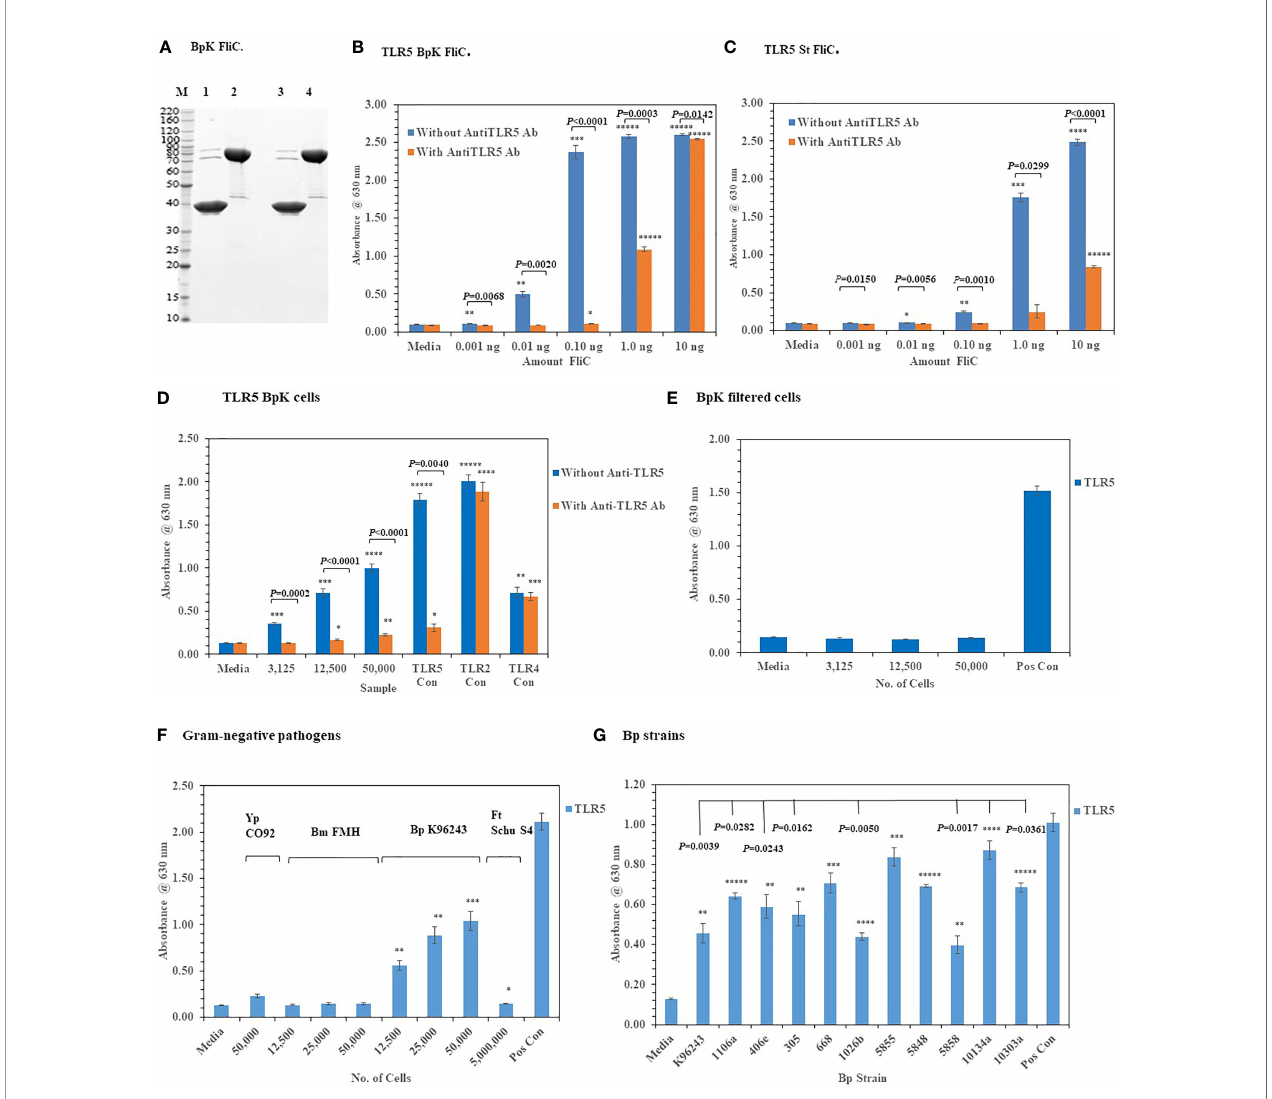
FIGURE 7 | Activation of TLR5 by either fl agellin or fl agella. (A) Polyacrylamide gel electrophoresis (10.5 − 14% Criterion, Tris-HCl gel) of puri fi ed Bp K96243 fl agellin preparations (5 µg each): M, marker; lane 1, FliC sample heated and reduced, prior to loading; lane 2, His6-MBP-tev-BpKFliC (uncleaved tev Bp K96243 FliC) sample heated and reduced, prior to loading; lane3, FliC, without heating or reducing; lane 4, His6-MBP-tev-BpKFliC without heating or reducing. (B) TLR5 activation by increasing amounts of Bp K96243 FliC with and without anti-TLR5 monoclonal antibody (100 ng). Signi fi cant differences in TLR5 activity with and without anti-TLR5 antibody are shown above. (C) TLR5 activation by increasing amounts of St FliC with and without anti-TLR5 monoclonal antibody (mAb) (100 ng). (D) Activation of TLR5 by live Bp K96243 cells can be inhibited by an anti-TLR5 mAb but not TLR2 or TLR4. Varying amounts of Bp K96243 cells was used to inoculate HEK293-TLR5 cells. Also, HEK 293 -TLR5, -TLR2, and -TLR4 cells with their respective positive control antigens were examined. All TLR activation samples were examined with and without anti-TLR5 mAb (100 ng). (E) Activation of TLR5 after fi ltration of Bp K96243 cells used in Figure 7D . Equivalent amounts of fi ltrate (in 20 µl) that contained 3,125, 12,500, and 50,000 Bp K96243 cells before fi ltration (0.2 µm) was added to HEK293-TLR5 cells and activation evaluated. The positive control was not fi ltered. (F) Activation of TLR5 by live Gram-negative pathogens. Gram-negative pathogens Yp CO92, Bm FMH, Bp K96243, and Ft Schu S4) were grown as described in the Material and Methods, and bacterial cell suspensions were used to inoculate HEK293-TLR5 cells. After overnight incubation (~20 h) at 37°C with 5% CO 2 , the absorbance of the plates were read at 630 nm. The media control was PBS, and the positive control (Pos Con) was St FliC (2 ng). (G) Activation of TLR5 by live cells of Bp spp. Bp spp. listed in Table 1 were grown as described in the Material and Methods and used to inoculate HEK293-TLR5 cells as indicated. After overnight incubation (~20 h) at 37°C with 5% CO 2 , the absorbance of the plates were read at 630 nm. Although different amounts of cells were examined for TLR5 activity (6,250, 25,000, and 100,000 cells), for display purposes we only show the results for 100,000 cells, which gave the highest activity in all cases except one strain (Bp 406e). In this latter case, there was no statistical difference between the two highest cell concentration used. Statistical differences between the Bp strain with highest TLR5 activity ( Bp HBPUB10134a) and the other strains is shown above in the fi gure. Results of TLR activation are presented as geometric mean with standard error of the mean. TLR5 activation samples were analyzed in triplicate and results represent one of two independent repeats. The media control was PBS. Signi fi cant differences between samples are shown above the results. Signi fi cant values compared to media control are shown: * P ≤ 0.05; ** P ≤ 0.01; *** P ≤ 0.001; **** P ≤ 0.0001; ***** P ≤